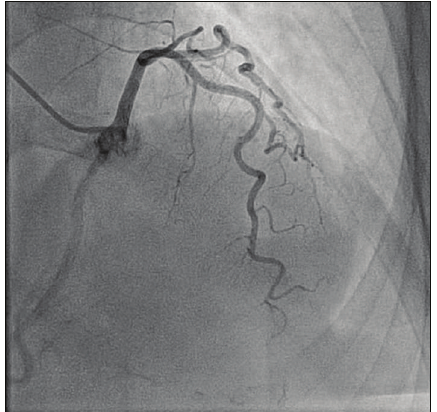
Figure 2: Left anterior oblique view of left main coronary artery with an anomalous origin off the right sinus of Valsalva with intraseptal course.